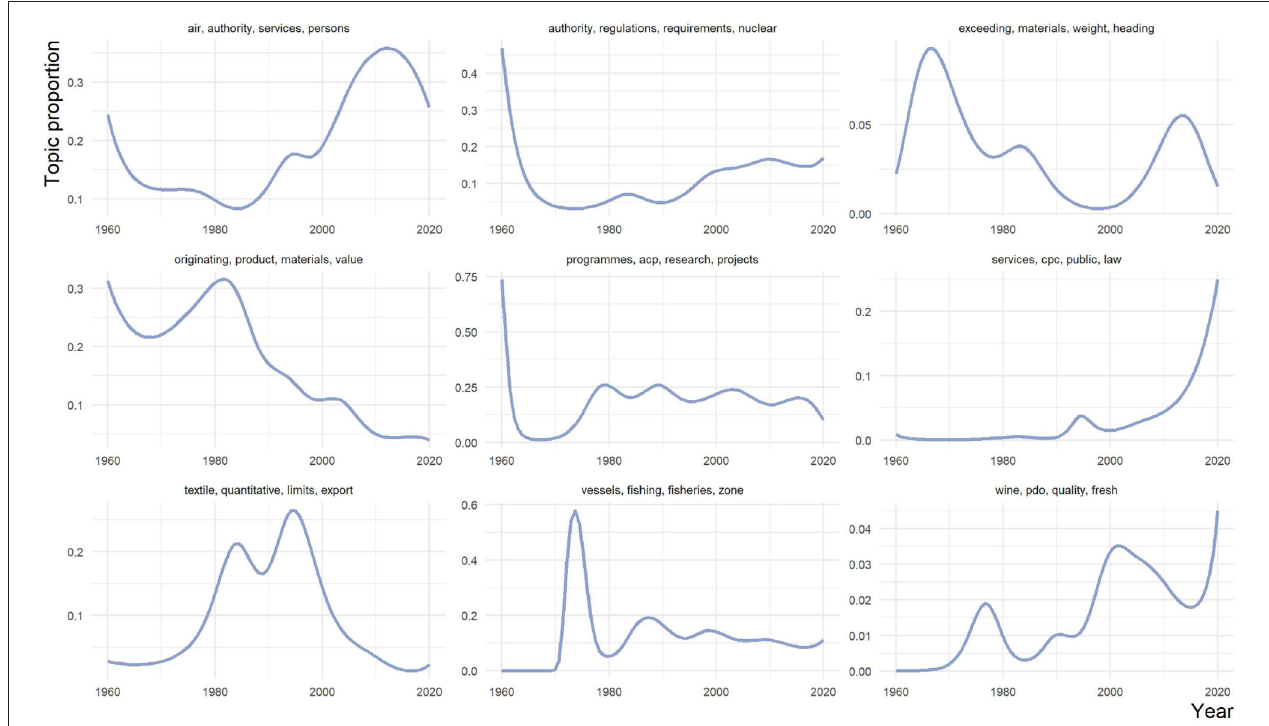
FIGURE 3 | Dynamic topic model of EU international agreements. Topics are summarized by their four most-characteristic